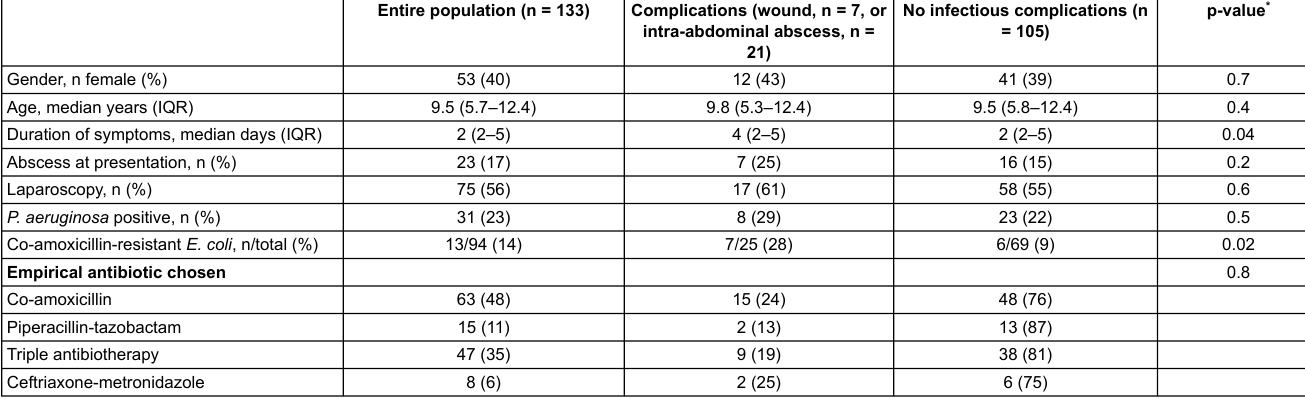
Table 1: Patient characteristics and risks factors for infectious complications.